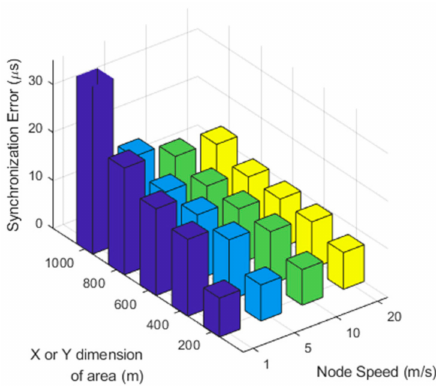
Figure 12. Network error with varying area size and node